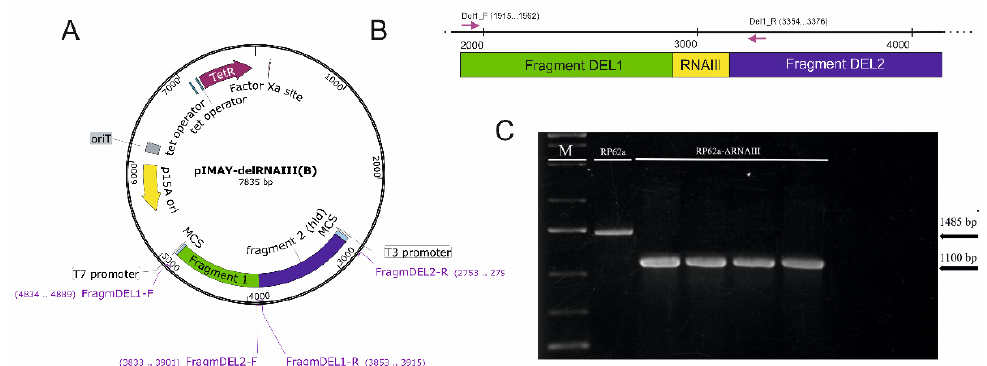
Figure 2. Preparation of S. epidermidis RP62a- Δ RNAIII. ( A ). Map of the pIMAY-delRNAIII plasmid used for allelic exchange containing deletion cassette. ( B ). Map of RP62a chromosomal DNA with the RNAIII deleted fragment of the repressor domains sequence with primers used for PCR confirmation of allelic exchange highlighted (green–downstream fragment, blue- upstream fragment, yellow–deleted sequence). ( C ). Electrophoresis gel of confirmation PCR of allelic exchange (1100 bp). As a control, chromosomal DNA of RP62a was used (1485 bp).